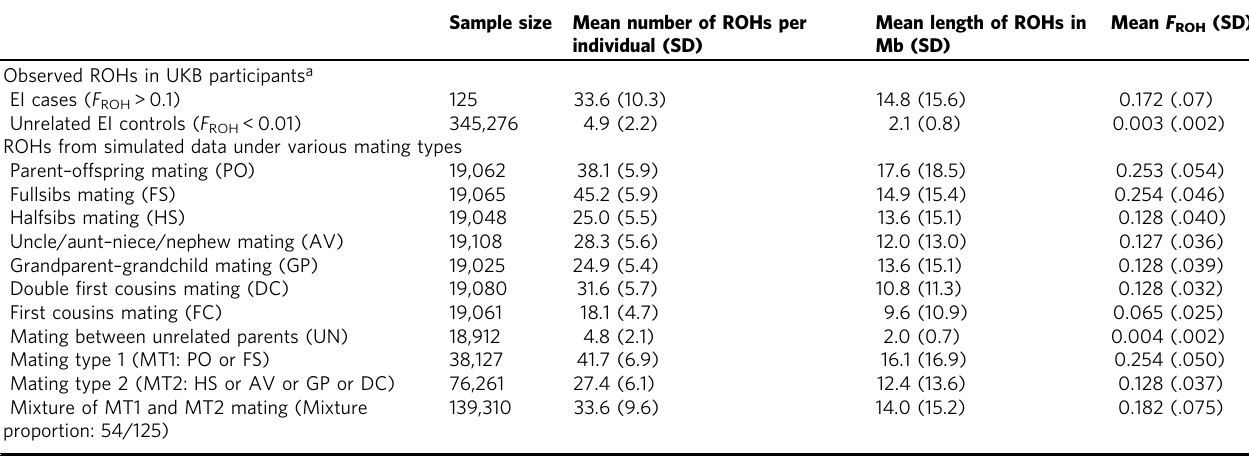
SD standard deviation a Mean differences between EI cases and controls are statistically signi fi cant at p <10 − 10